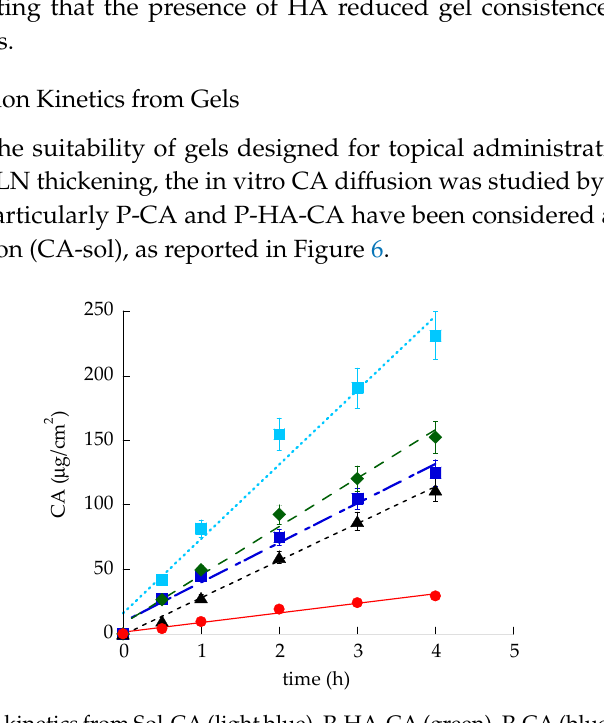
Figure 6. CA di ff usion kinetics from Sol-CA (light blue), P-HA-CA (green), P-CA (blue), SLN-CA (black), and SLN-P-CA (red), as determined by Franz cell. Data are the mean of 6 independent experiments. Di ff usion profiles fitted well with zero-order kinetics. It should be considered that in the case of sol-CA, CA concentration was 0.5 mg / ml, thus the di ff usion coe ffi cient (D), obtained dividing flux by CA concentration within the formulation, was double with respect to the flux (Table 6). CA fluxes